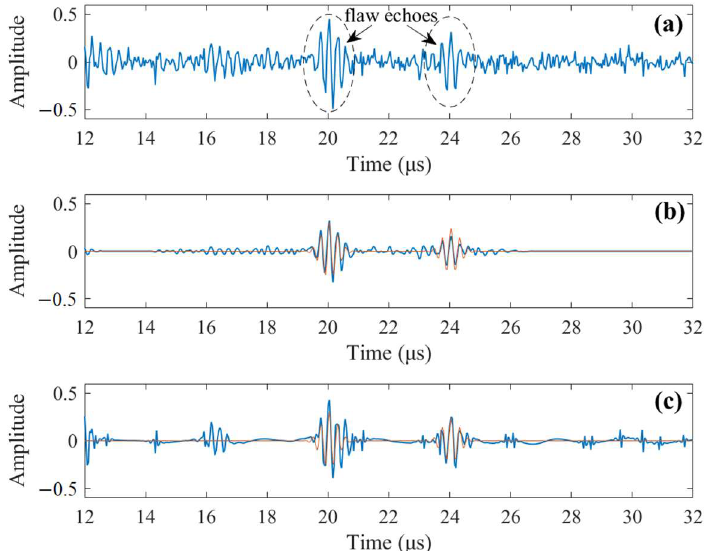
Figure 6. ( a ) The analyzed signal segment containing two flaw echoes, NSNR = 0.5946. ( b ) De-noised signal by our method along with noise-free flaw echoes, NSNR = 0.9488 (blue line: reconstructed signal; red line: original noise-free echoes). ( c ) De-noised signal by DWT (level-4 sym25) along with noise-free flaw echoes, NSNR = 0.7378 (blue line: reconstructed signal; red line: original noise-free echoes).